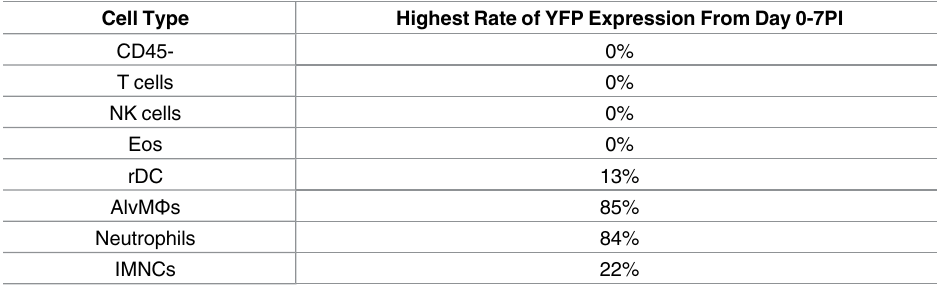
Table 1. Pulmonary YFP expression in LysM-Cre x ROSA26 reporter mice prior to and during IAV infection. Cell